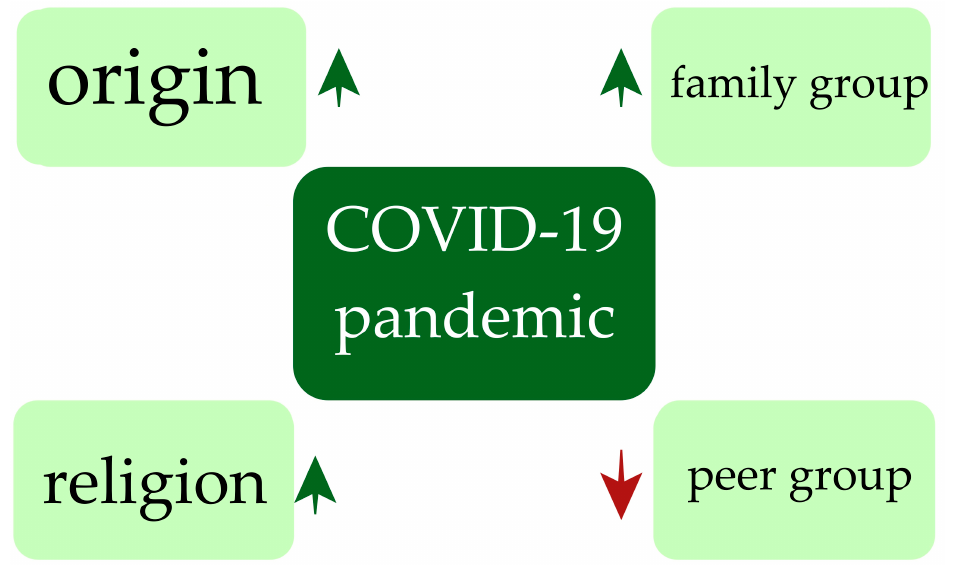
Figure 2. Effect of COVID-19 pandemic on availability of support through group affiliation. ( ↑— increase in support; ↓ —decrease in support). Table 2. Number data of suicidal behaviors during the COVID-19 pandemic.